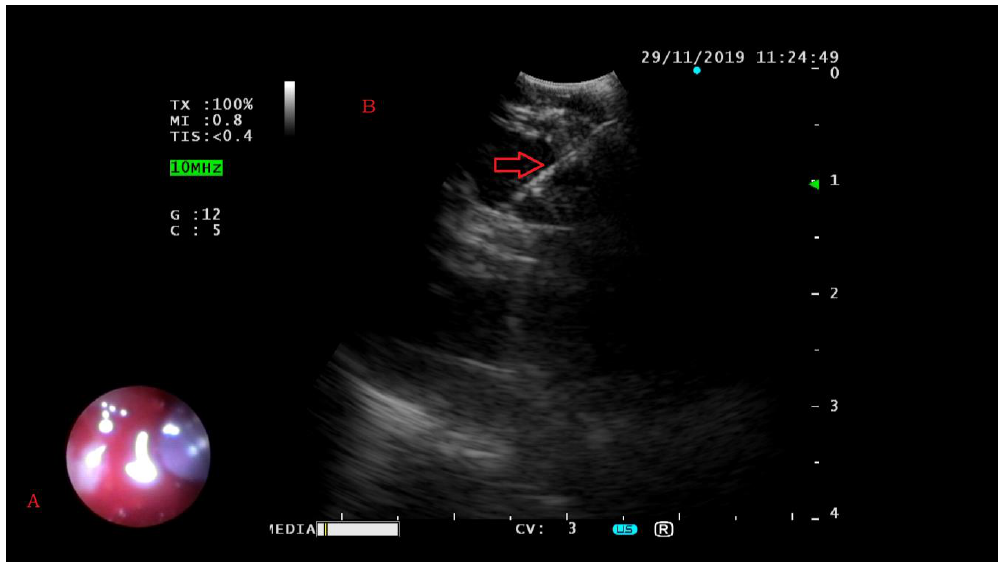
Figure 2. Trachea view by endoscopy ( A ). Introduction of fine needle into target lesions (red arrow) under real-time EBUS ( B ).